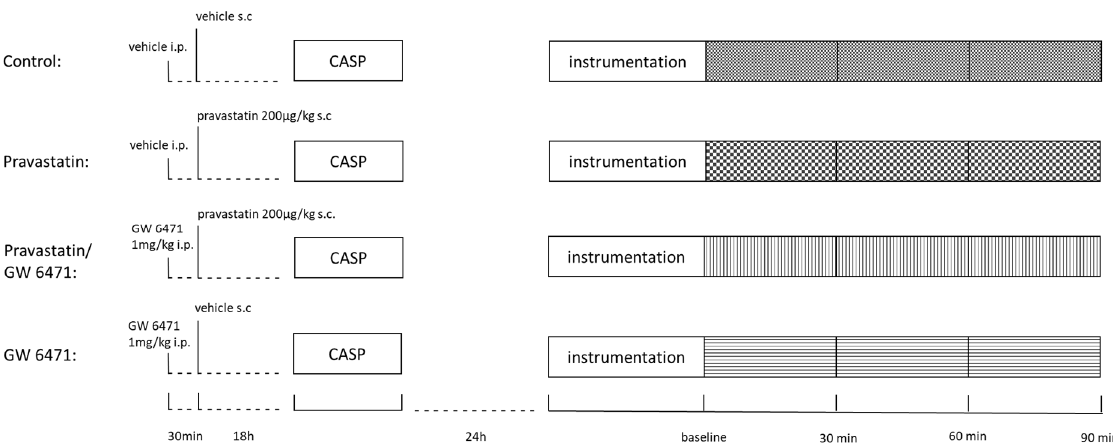
Figure 6. The sequence of experimental procedures. Pravastatin or vehicle were injected s.c. 18 h before the colon ascendens stent peritonitis (CASP)-operation, the PPAR- α -blocker GW6471 30 min prior the application of pravastatin. The experiments were performed 24 h after the CASP-operation.